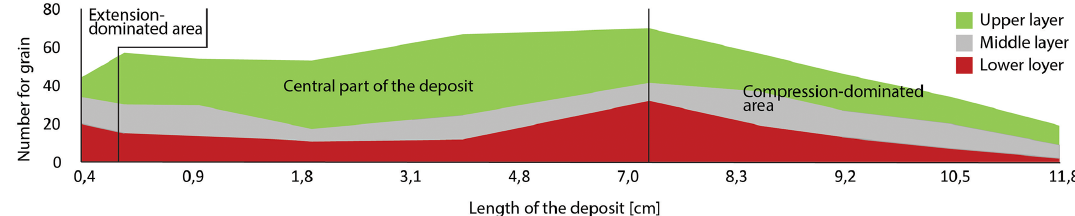
Figure 12. Repartition of the colored sand grains within the